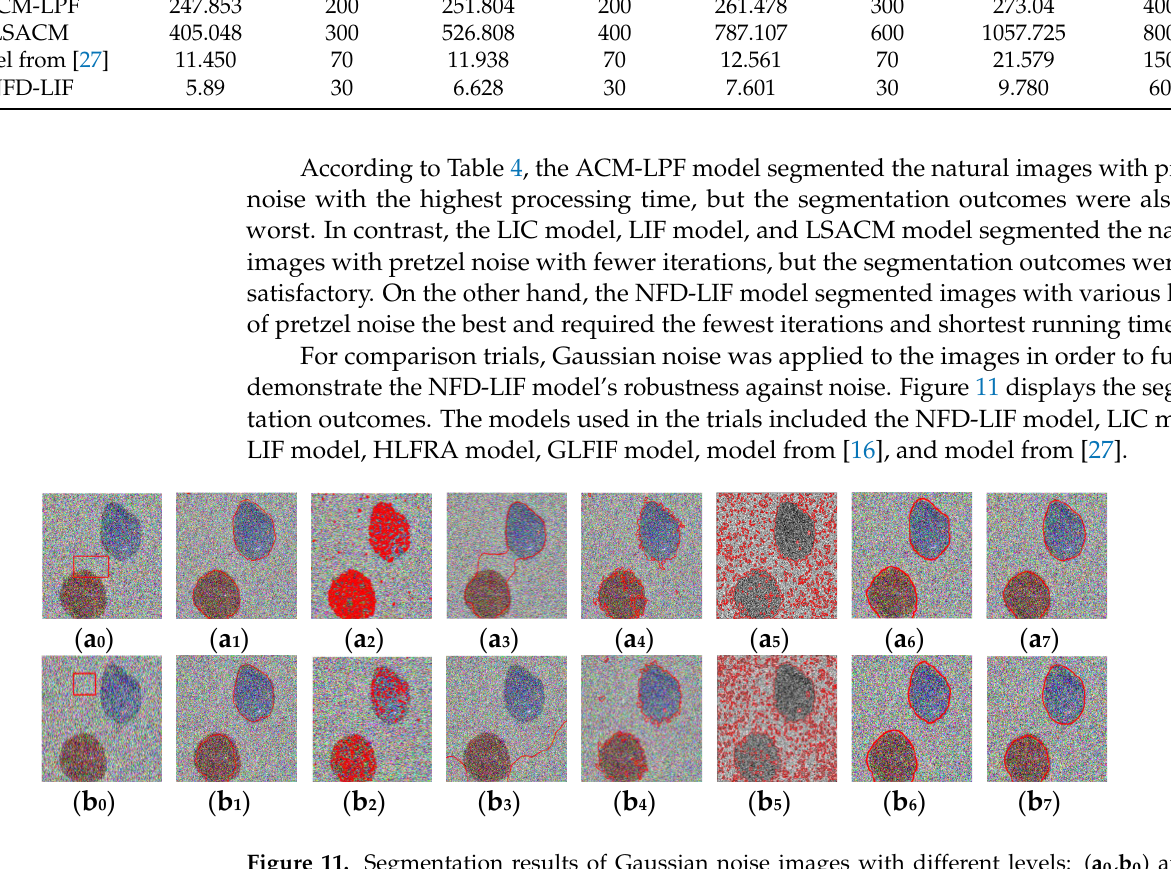
Figure 11. Segmentation results of Gaussian noise images with different levels: ( a 0 , b 0 ) are the Gaussian noise images with a mean of 0 and variances of 0.08 and 0.1, respectively. ( a 1 , b 1 ) are the results of the segmentation using the model from [16]. ( a 2 , b 2 ) are the results of the HLFRA model segmentation; ( a 3 , b 3 ) are the results of the GLFIF model segmentation. ( a 4 , b 4 ) are the results of the LIC model segmentation. ( a 5 , b 5 ) are the results of the LIF model segmentation. ( a 6 , b 6 ) are the results of the segmentation using the model from [27]. ( a 7 , b 7 ) are the results of the NFD-LIF model segmentation.